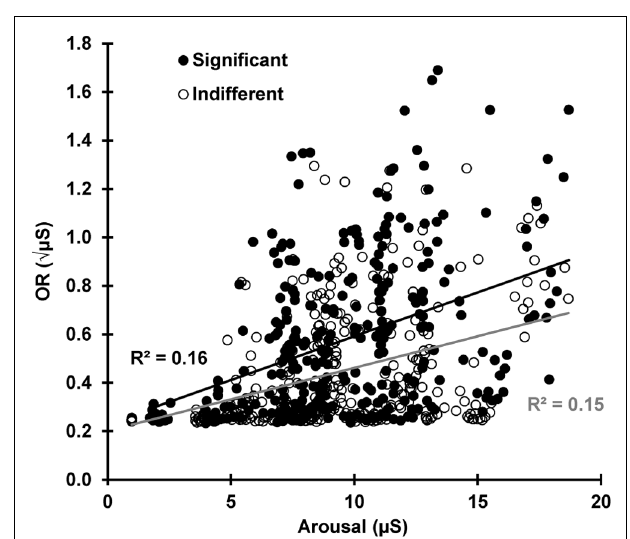
previous OR at trial 11, as that response has already resolved.